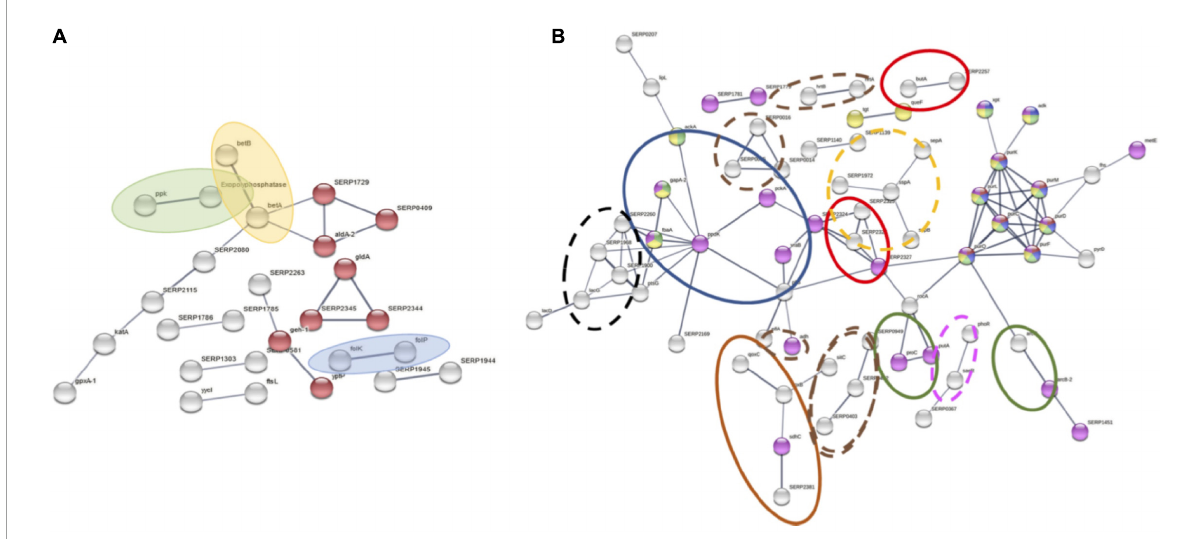
FIGURE4 STRING network of differentially abundant proteins between N55 and N77 conditions. Proteins increased (A) and decreased (B) in condition N55 when compared with N77. (A) Proteins associated with glycerolipid metabolism are represented as red nodes. Blue, yellow and green shadowed ellipsis highlight proteins involved in folate and betaine biosynthesis and phosphate metabolism. (B) Proteins associated to purine and nucleotide metabolism are represented as red, purple, green and yellow nodes, while those associated with the biosynthesis of secondary metabolites are represented as pink nodes, including proteins involved in glycolysis/gluconeogenesis/pyruvate metabolism, oxidative phosphorylation, acetoin catabolism arginine and proline metabolism circled by blue, orange, red and green open ellipsis. The other clusters highlighted with dashed black, brown, yellow and magenta ellipsis are the phosphoenolpyruvate:sugar phosphotransferase system (PTS), membrane transporters, extracellular proteases and the SaeRS two-component signal transduction system